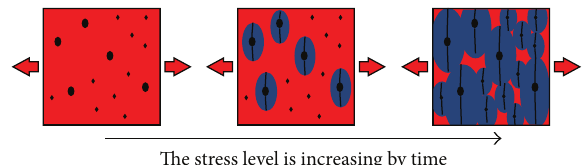
Figure 6: Obscuration phenomenon and multiple fragmentation process.